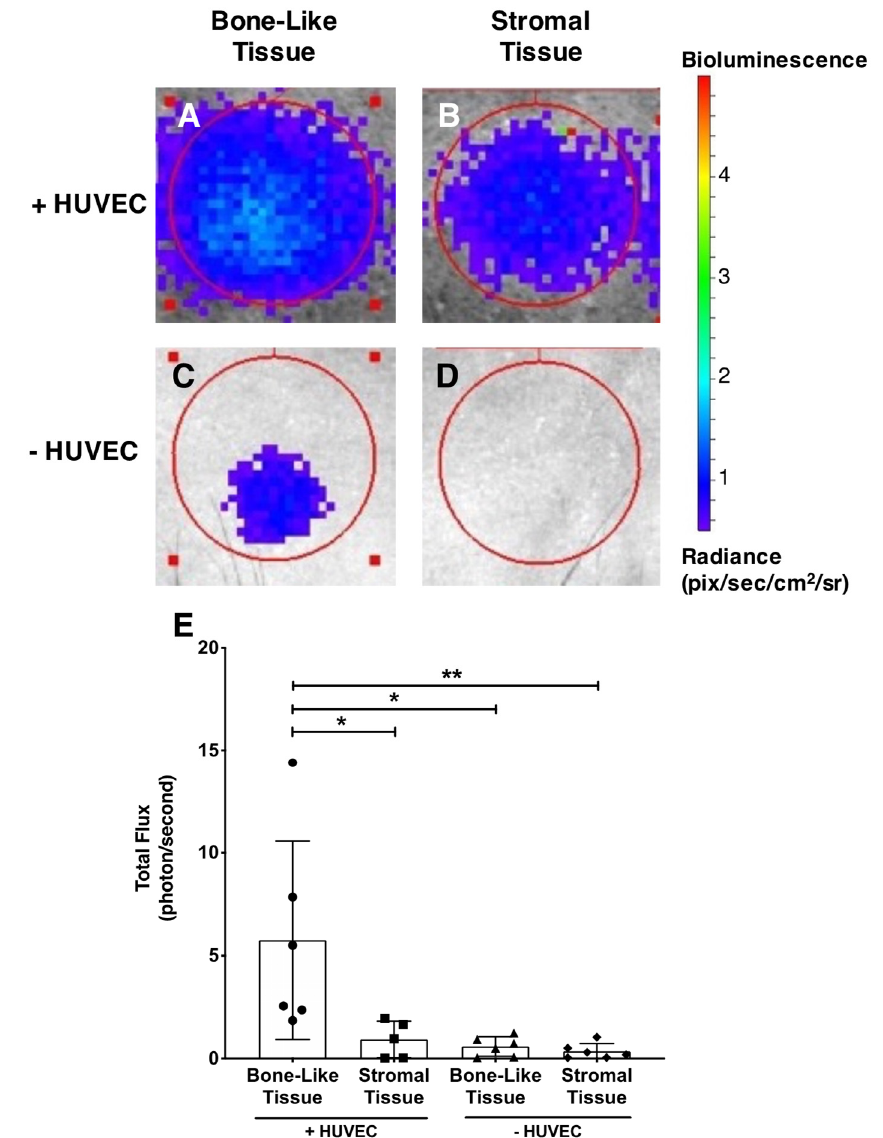
Figure 8. Functional analysis of hASC-Luc-derived cells in reconstructed substitutes after 12 weeks of implantation. The bioluminescence emitted by hASCs-Luc composing the grafted tissues was imaged 15 min after intraperitoneal luciferin injection using an IVIS ® Lumina II device ( A – D ). Red circles indicate both the size of the original 5 mm diameter bone defect and ROI for bioluminescent signal acquisition. The prevascularized (+HUVEC) bone-like substitutes emitted mean elevated levels of bioluminescence compared to prevascularized stromal tissues, as well as non-prevascularized substi- tutes ( − HUVEC, bone-like and stromal) after 12 weeks of implantation ( E ). The normal distribution of the data set was validated with a Shapiro–Wilk test, and Grubb’s method (Alpha = 0.1) was used to identify and remove outliers. A one-way ANOVA was then used with a Bonferroni’s multiple comparisons post hoc test, * p < 0.05, ** p <